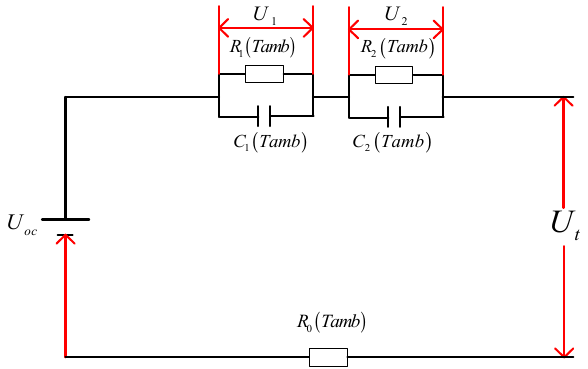
Figure 1. DP equivalent circuit diagram.